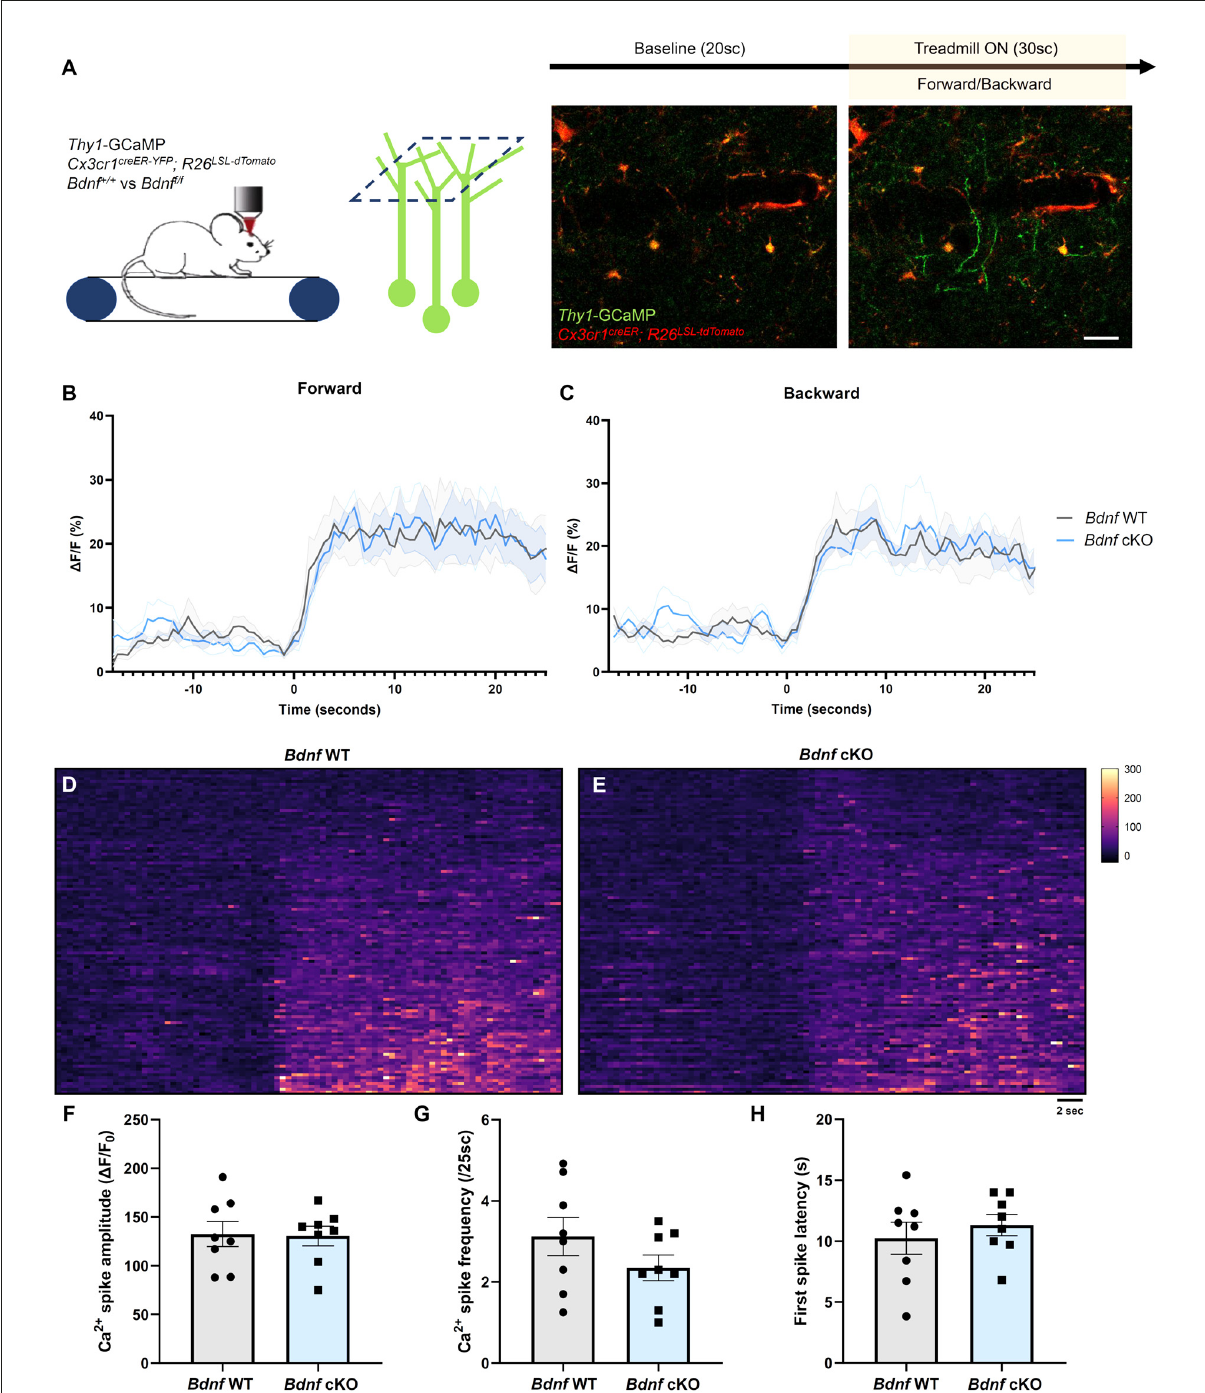
FIGURE2 Deletion of microglial Bdnf does not affect dendritic activity. (A) Paradigm to assess training-induced dendritic activity using two-photon imaging of Thy1 -GCaMP6s in L1 of the motor cortex, and representative example of dendritic activity after the treadmill was turned on. (B,C) Average Ca 2+ activity in the neuropil of Thy1 -GCaMP6s; Cx3cr1 creER − YFP / + ; R26 LSL − tdTomato / + ; Bdnf +/+ ( Bdnf WT) mice and Thy1 -GCaMP6s; Cx3cr1 creER − YFP / + ; R26 LSL − tdTomato / + ; Bdnf f / f littermates ( Bdnf cKO). No difference was observed between genotypes during (B) forward or (C) backward running (eight training sessions from four animals in each group). (D,E) Heatmaps of dendritic Ca 2+ activity (112 dendrites measured from two sessions, from four animals in each group). (F–H) Dendritic Ca 2+ spike analysis ( n = 8 sessions from four animals in each group) showing (F) no significant difference in spike amplitude ( p = 0.9, unpaired t -test), (G) no significant difference in spike frequency ( p = 0.2, unpaired t -test) and (H) no significant difference in first spike latency from training onset ( p = 0.5, unpaired t -test). Scale bar: 10 µ